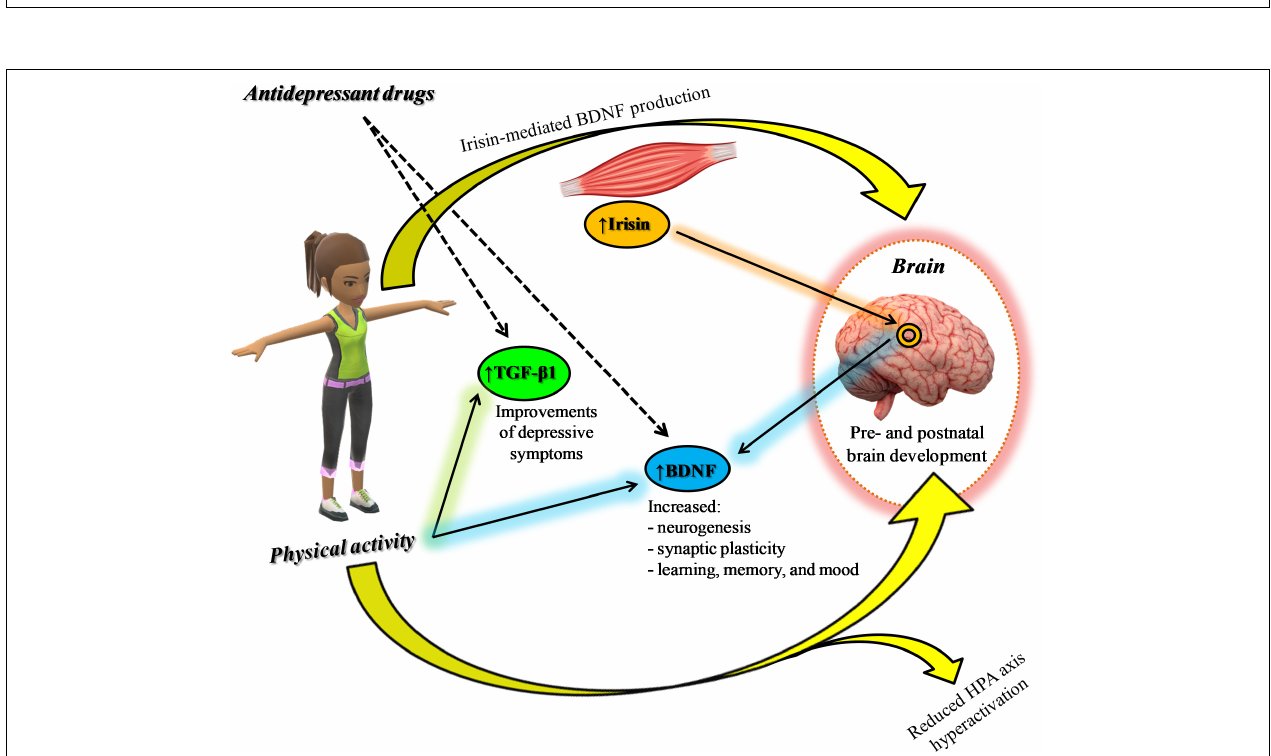
FIGURE 2 | Synergic effect between physical activity and antidepressants: positive modulation of neurotrophic factors.